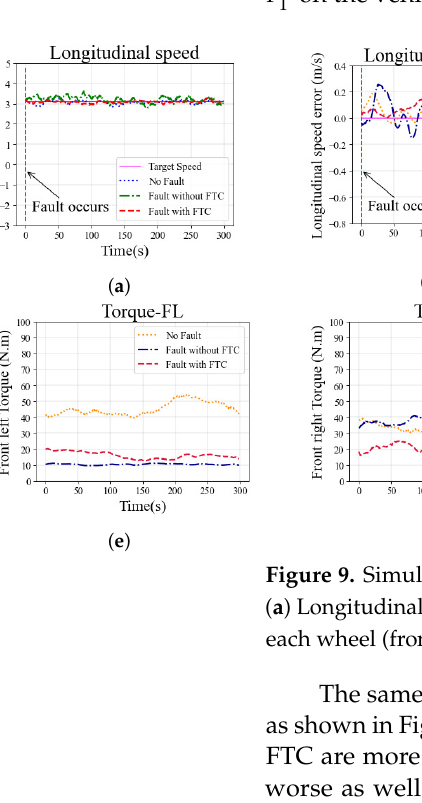
F ∗ on the vehicle. 1